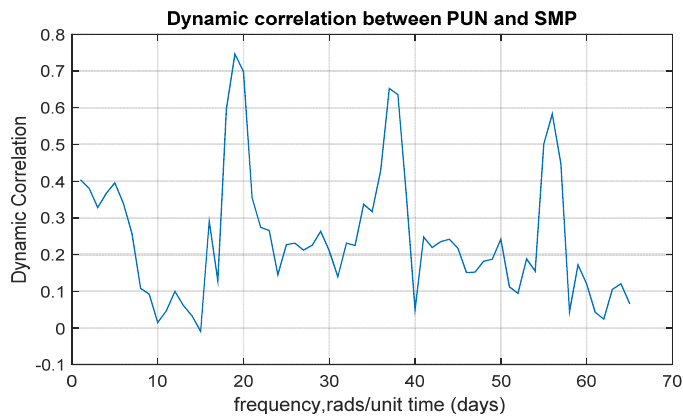
Figure 17. Dynamic correlation between the SMP and PUN daily time series, after applying relation Equation (14), Section 3.2.